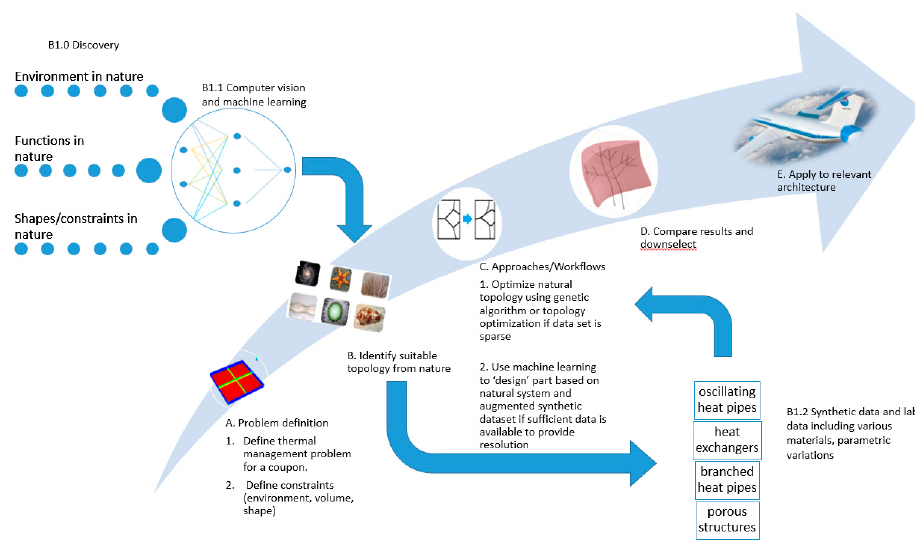
Figure 4. Hybrid machine learning and biomimetic approach to problem solving.